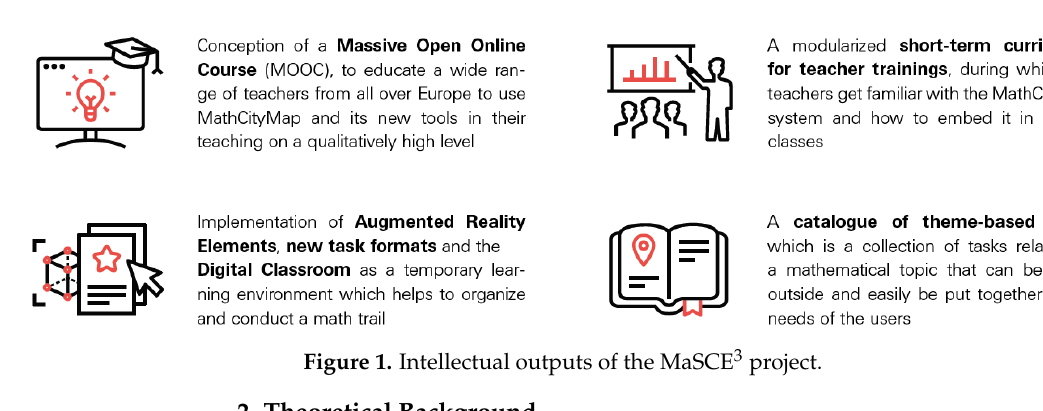
Figure 1. Intellectual outputs of the MaSCE³ project.